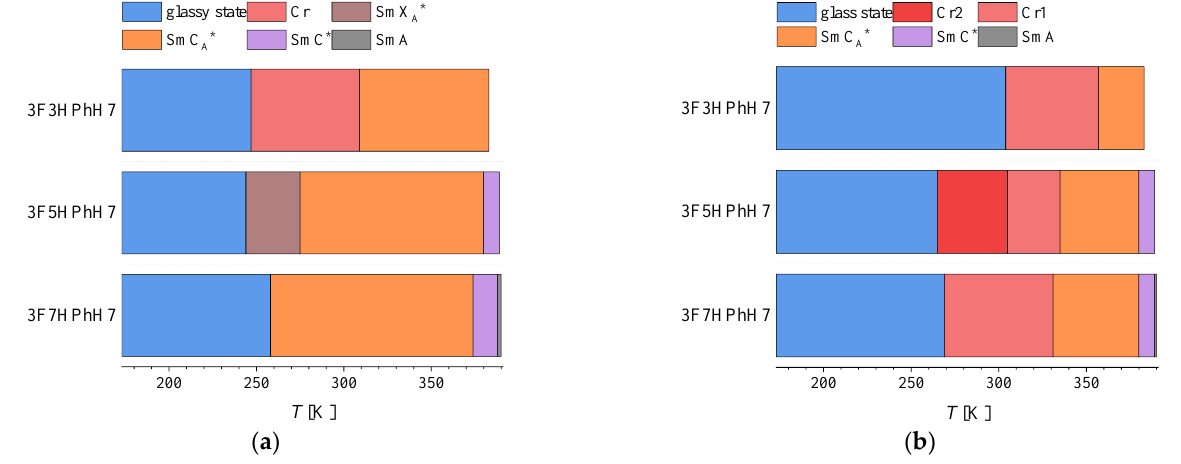
Figure 9. Phase sequence of 3F m HPhH7 homologues upon fast cooling ( a ) and subsequent heating ( b